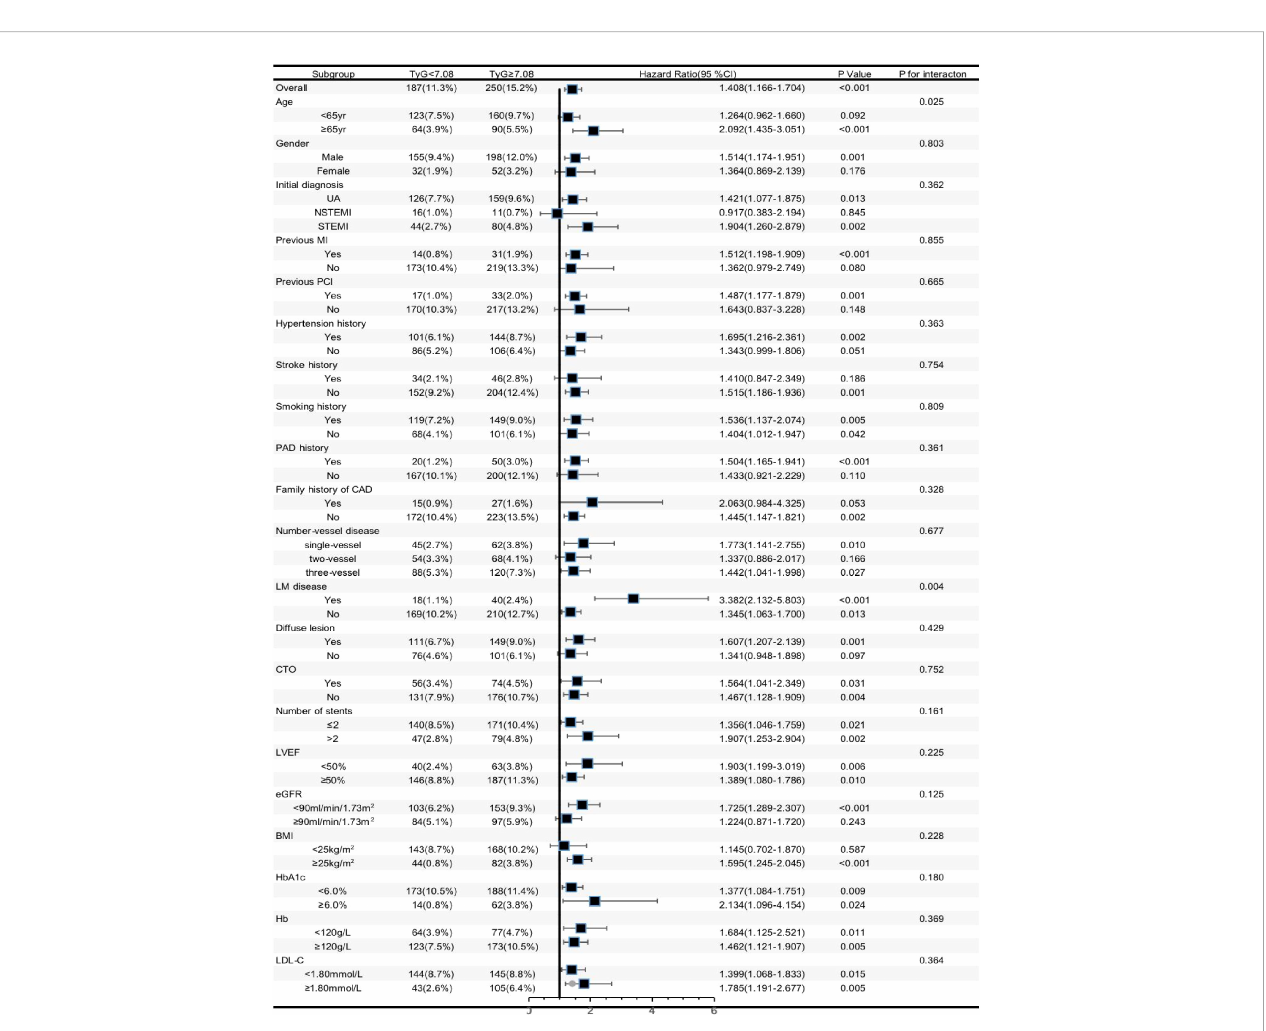
FIGURE 3 Forest plot investigating the association between the TyG index and MACCE in different subgroups. TYG, triglyceride-glucose index; UA, unstable angina, NSTEMI, non ST-segment elevation myocardial infarction; STEMI, ST-segment elevation myocardial infarction; MI, myocardial infarction; PCI, percutaneous coronary intervention; DM, diabetes mellitus; CAD, coronary artery disease; LM, left main; CTO, chronic total occlusion; Hb, hemoglobin; LVEF, left ventricular ejection fraction; eGFR, estimated glomerular fi ltration rate; BMI, body mass index; HbA1c, glycosylated hemoglobin A1c; HDL-C, high-density lipoprotein cholesterol, LDL-C, low-density lipoprotein cholesterol; C, con fi dence